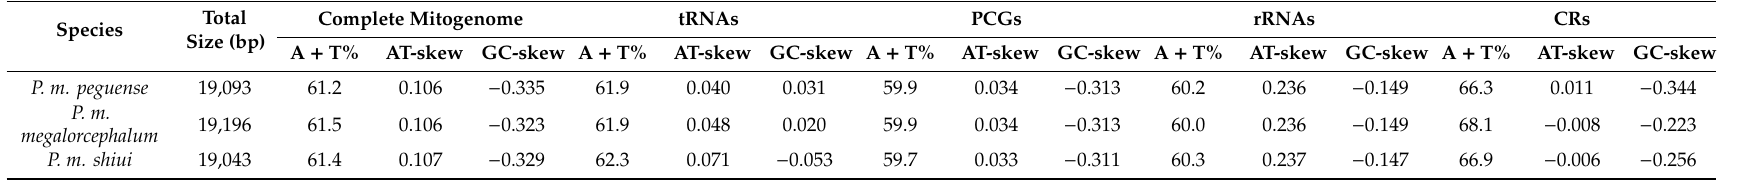
Table 2. Base composition and skewness of the Platysternon mitogenomes of three